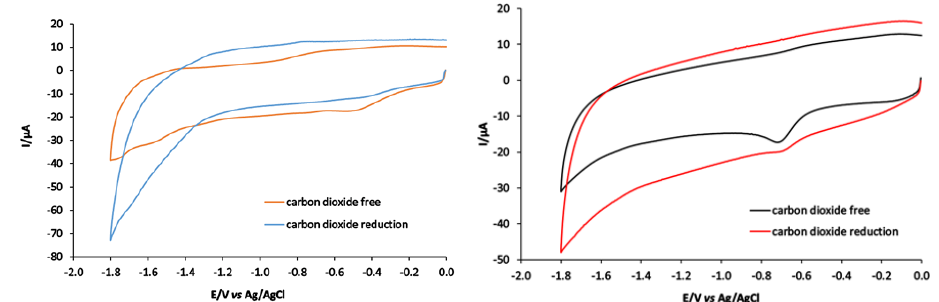
Figure 8. CV of 0.4 mM solution of compounds 1 and 2 at a vitreous carbon electrode in DMF 0.2 M [NBu 4 ][BF 4 ] ; scan rate 100 mV s −1 under N 2 and CO 2 at 1 atmosphere.